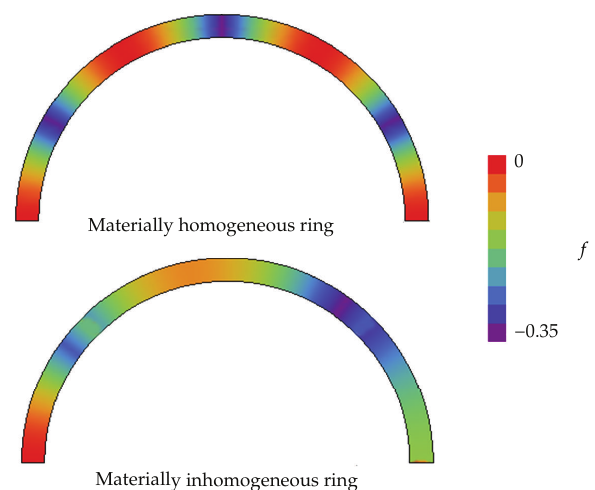
Figure 8: Contour plot of the yield function values, f , for the homogeneous and the inhomogeneous cases at the complete yielding of the first section along the circumference (cid:6) t (cid:8) 26 mm, D (cid:8) 457 . 2mm, ω (cid:8) 1 / 1000, n (cid:8) 3, and θ c (cid:8) π/ 4 (cid:7) .